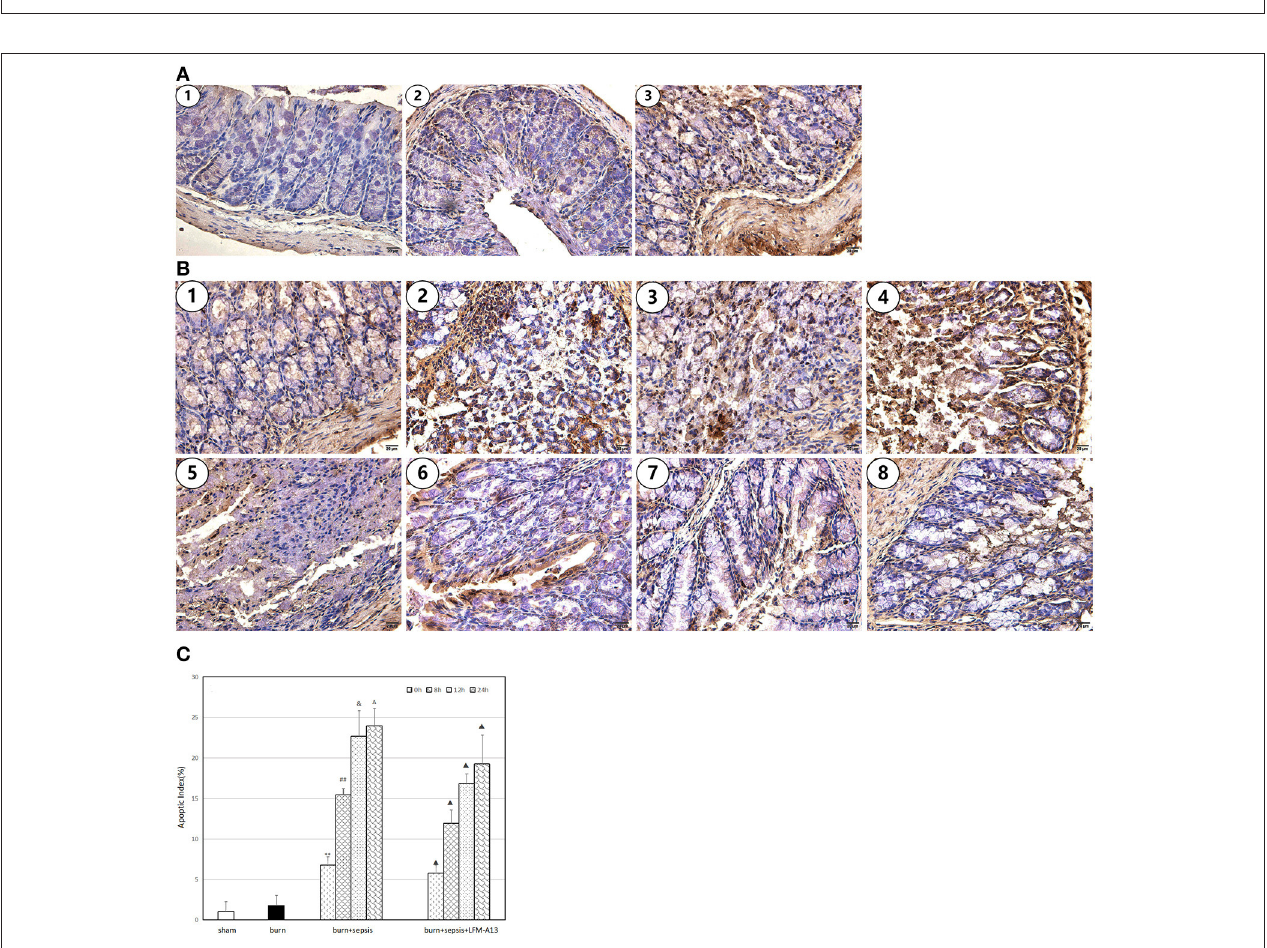
FIGURE 2 | at 12h ( × 100 and × 400), (6) the burn + sepsis group at 24h ( × 100 and × 400), (7) the burn + sepsis + LFM-A13 group at 0h ( × 100 and × 400), (8) the burn + sepsis + LFM-A13 group at 8h ( × 100 and × 400), (9) the burn + sepsis + LFM-A13 group at 12h ( × 100 and × 400), (10) the burn + sepsis + LFM-A13 group at 24h ( × 100 and × 400). (B) Histopathology scores in each group at different time points of post-burn. ** P < 0.01, vs. the sham group and burn group; in the burn + sepsis group, # P > 0.05, vs. 0h; & P > 0.05, vs. 8h; 1 P > 0.05, vs. 12h; N P < 0.05, NN P < 0.01, vs. the burn + sepsis group at corresponding time points except 0h of post-burn.